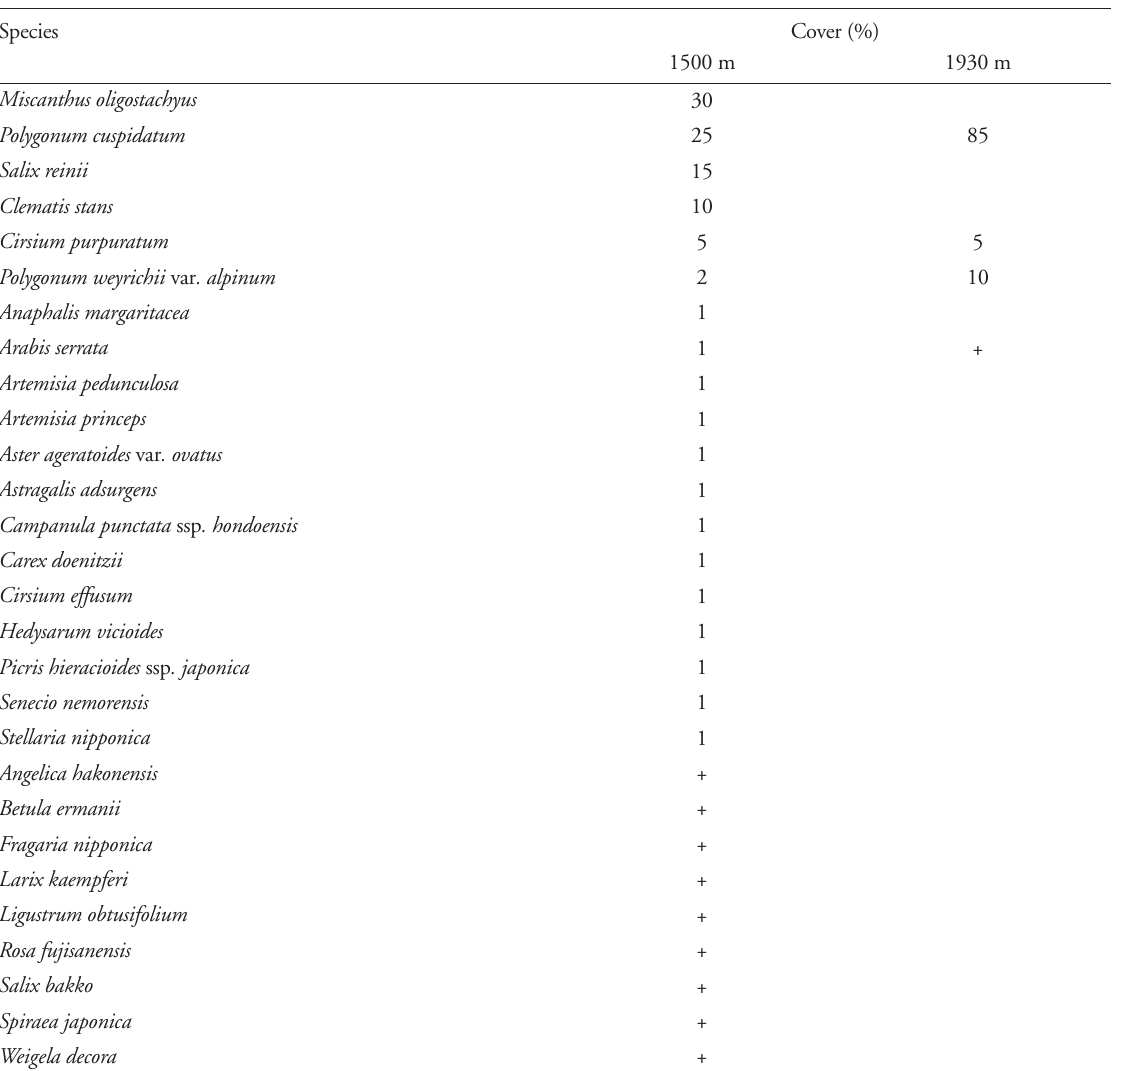
Table 1. Plant community structure at sites of different elevations (m a.s.l.), volcanic desert of Mount Fuji, Japan. Empty cells denotes absence of the species, and + refers to < 1% cover.